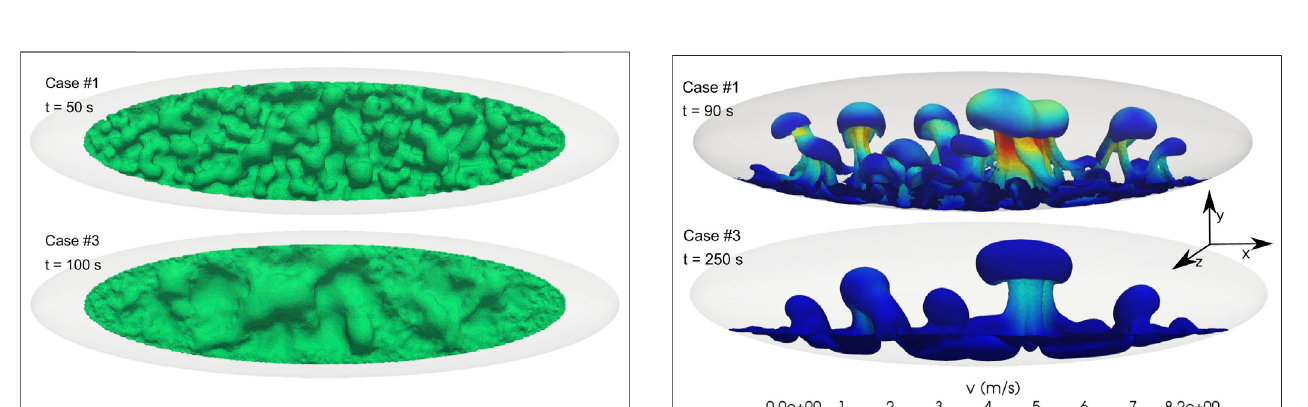
two cases 1 and 3. That maximum velocity corresponds to 8.2 m/s in case 1, while it is only 3.5 m/s for the more viscous case 3.